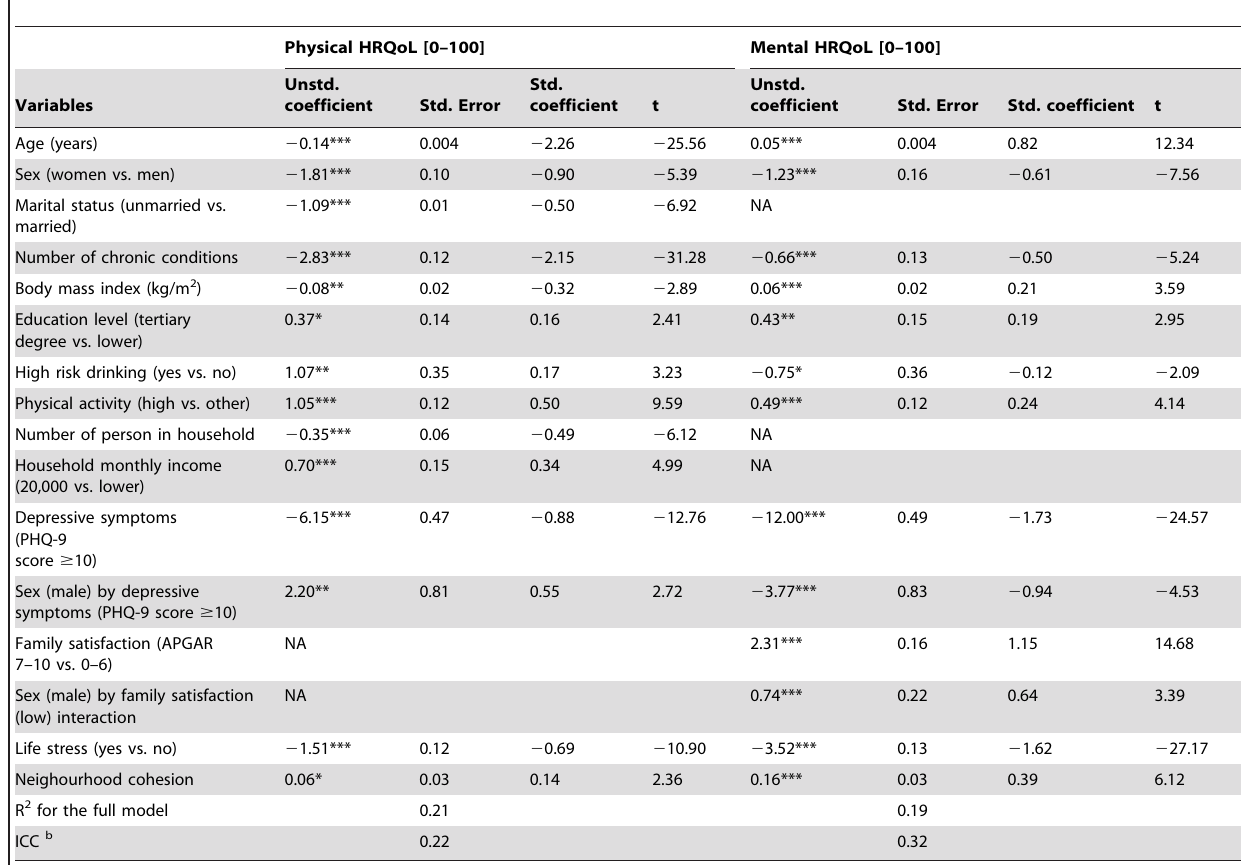
Table 3. The multilevel regression model of health related quality of life a with demographic variables, depressive symptoms and family satisfaction in the Chinese population aged 20 and above (N=